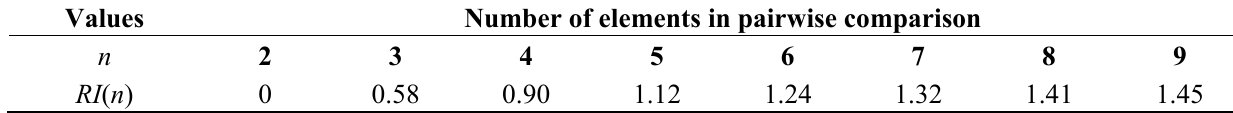
Table 1. Values of random index ( RI ) [30].